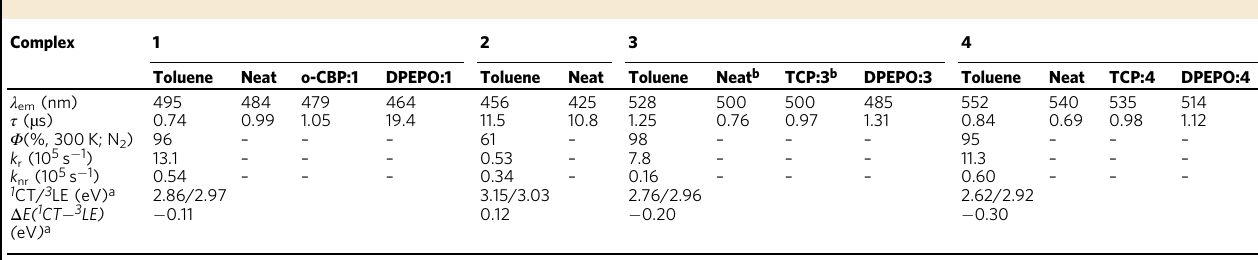
Table 3 Photophysical properties.